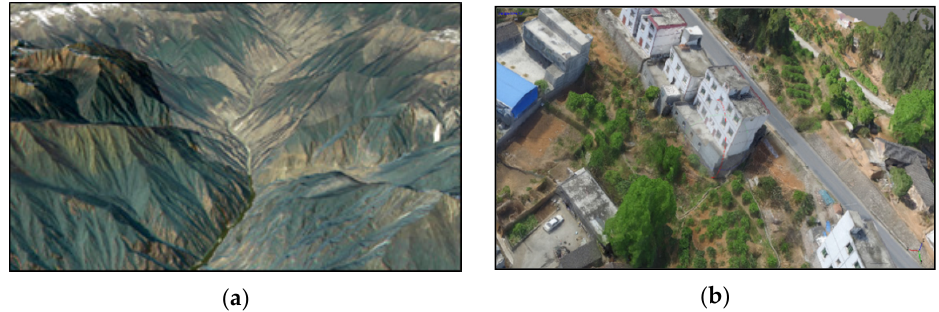
Figure 7. Three-dimensional real scene terrain: ( a ) large-scale 3D terrain; ( b ) detailed 3D terrain.